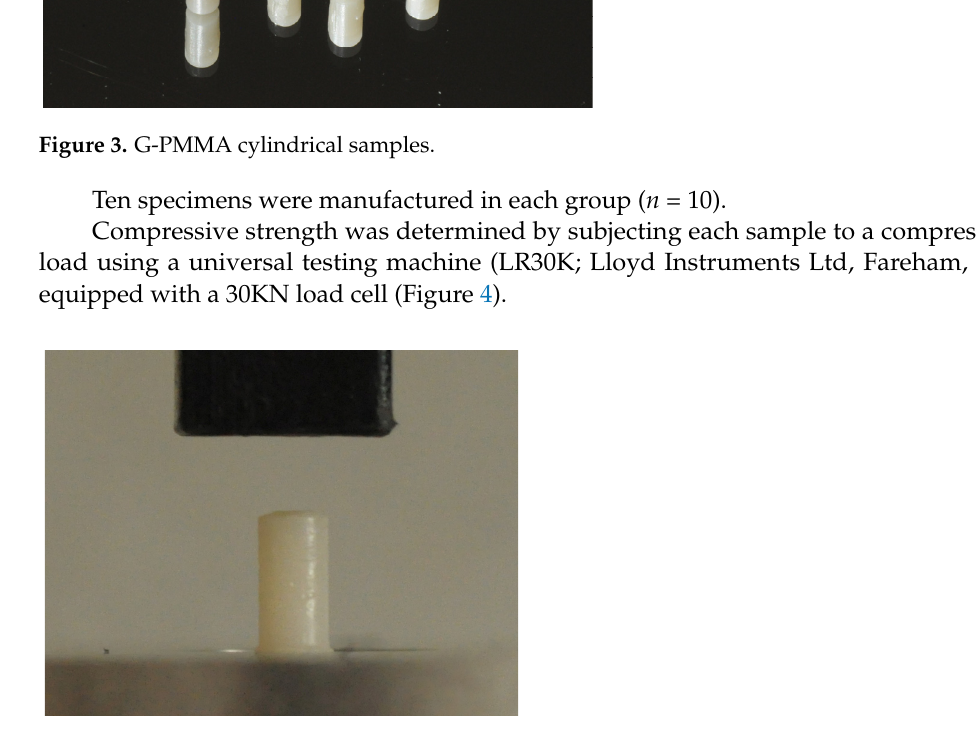
Figure 3. G-PMMA cylindrical samples.